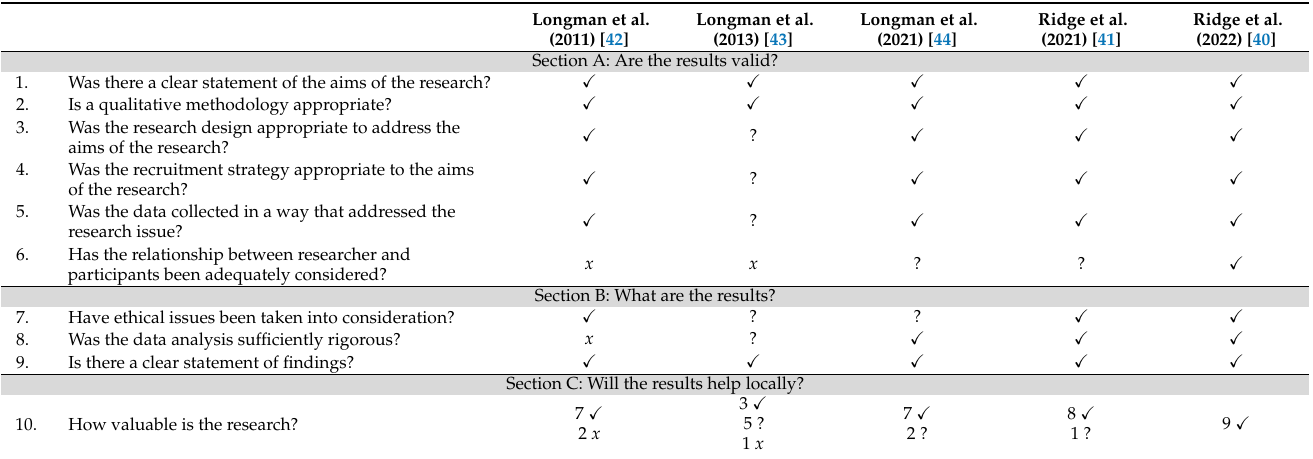
Section A: Are the results valid?